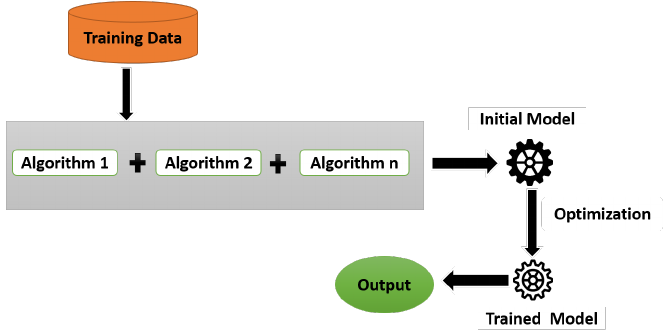
Figure 8. Architecture of Hybrid Machine